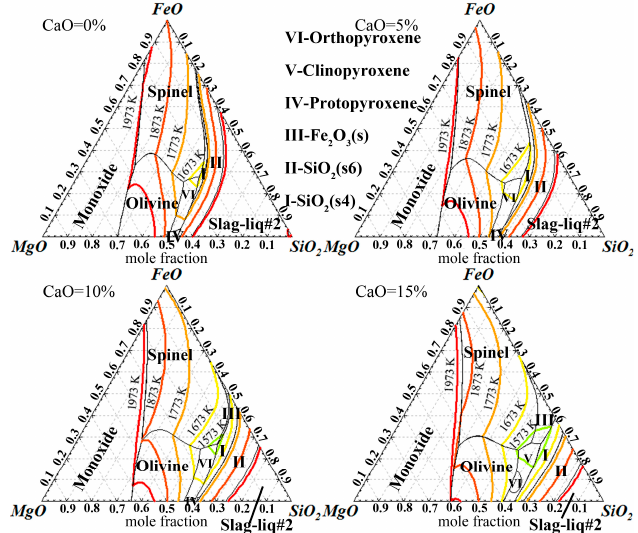
Figure 4. Liquidus projections of FeO-SiO 2 -MgO-CaO-O 2 with various levels of CaO addition.